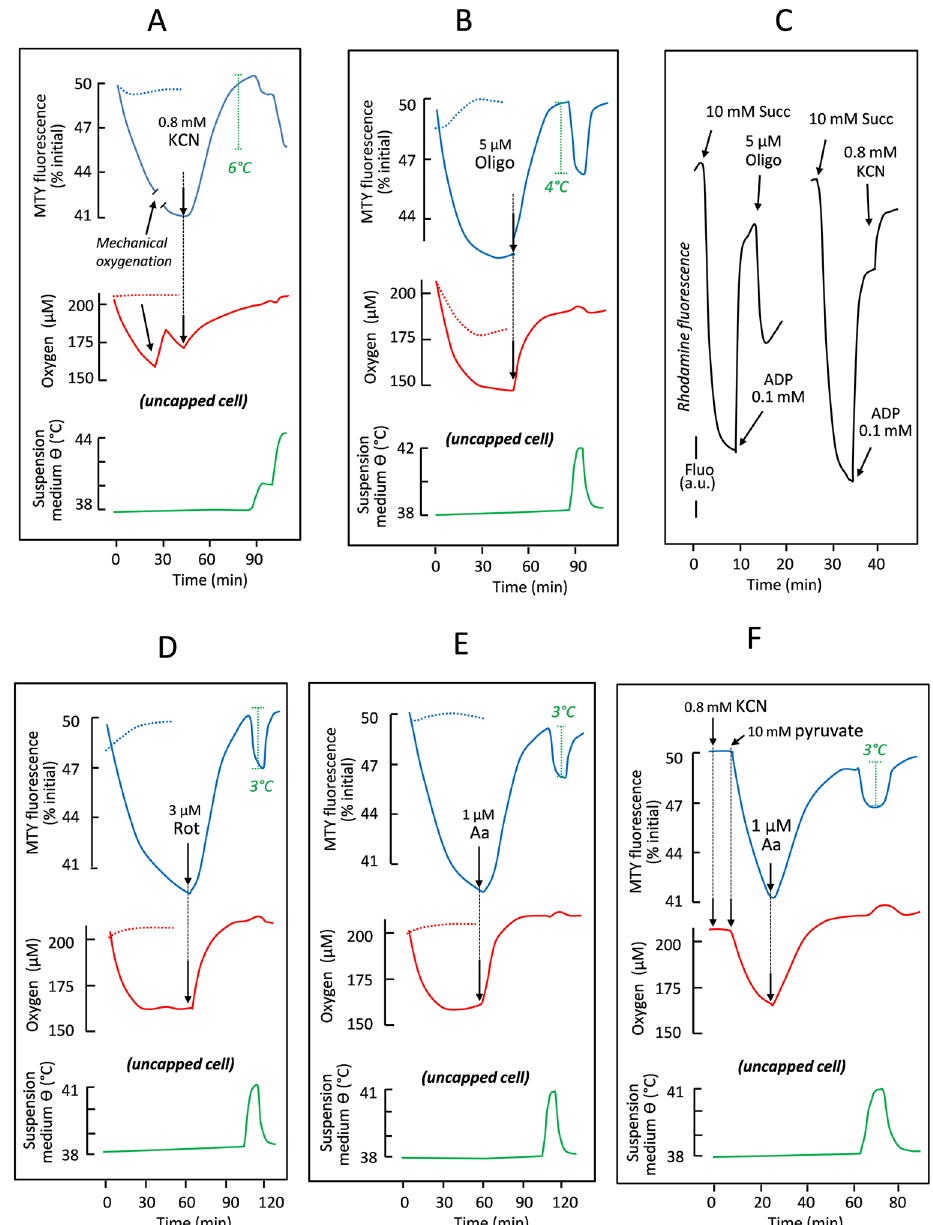
Fig 2. The rate of respiratory electron flow determines the temperature of mitochondria in intact HEK293 cells. (A) The effect of 0.8 mM cyanide on MTY fluorescence (blue lines) and cell respiration (red lines), when added under aerobic conditions (continuous lines), or when present from the start of the experiment (dotted lines). Changes in the temperature of the cell suspension medium (green line), imposed by water-bath adjustment, were used to calibrate the MTY fluorescence changes. (B) The effect of 5 μM oligomycin on MTY fluorescence (blue lines) and oxygen tension (affected by cell respiration balanced by medium stirring) in the uncapped quartz-cuvette (red lines), when added to freely respiring cells (continuous lines) or when present from the start of the experiment (dotted lines). (C) The effects of different inhibitors on rhodamine fluorescence, in digitonin (0.01%)-permeabilized HEK293 cells supplied with 10 mM succinate and 0.1 mM ADP, as indicated. Under state 3 conditions, 5 μM oligomycin and 0.8 mM potassium cyanide have qualitatively opposite effects on rhodamine fluorescence, used as an indicator of membrane potential ( Δ C ). The effects of 3 μM rotenone (D) and 1 μM antimycin (E) on MTY fluorescence and oxygen tension, plotted as for oligomycin in (B). (F) The effect of adding pyruvate on MTY fluorescence (blue line) and oxygen uptake (red line) by KCN-inhibited HEK293 cells. Temperature calibration (green line) of MTY fluorescence as in (A). Note that, in all experiments in which MTY fluorescence was measured prior to respiratory inhibition, the value reached at the end